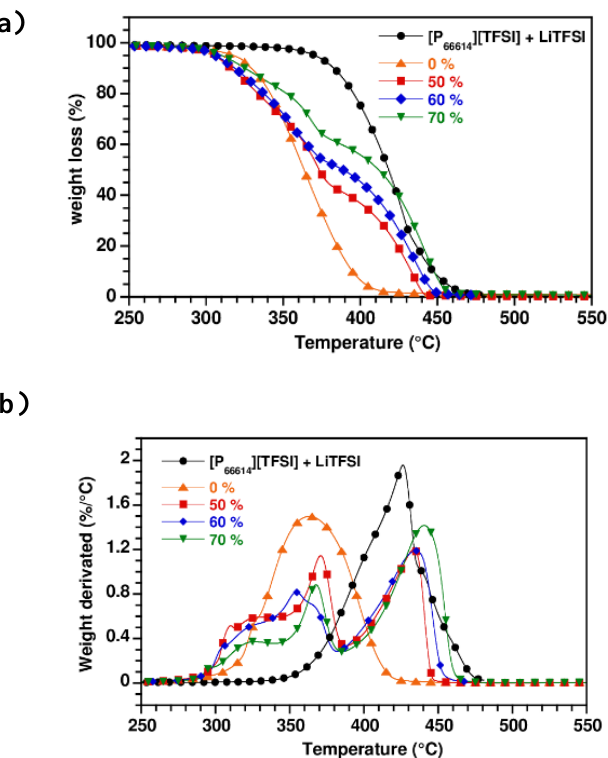
Figure 5. Thermo-gravimetric analyses (TGA) ( a ) and dynamical mechanical analysis (DTG) ( b ) of electrolyte ([P 66614 ][TFSI] + 0.75 M LiTFSI) alone and introduced in PPO-Jeffamine networks prepared with an electrolyte varying content (heating ramp: 10 K·min − 1 ; atmosphere: Nitrogen).